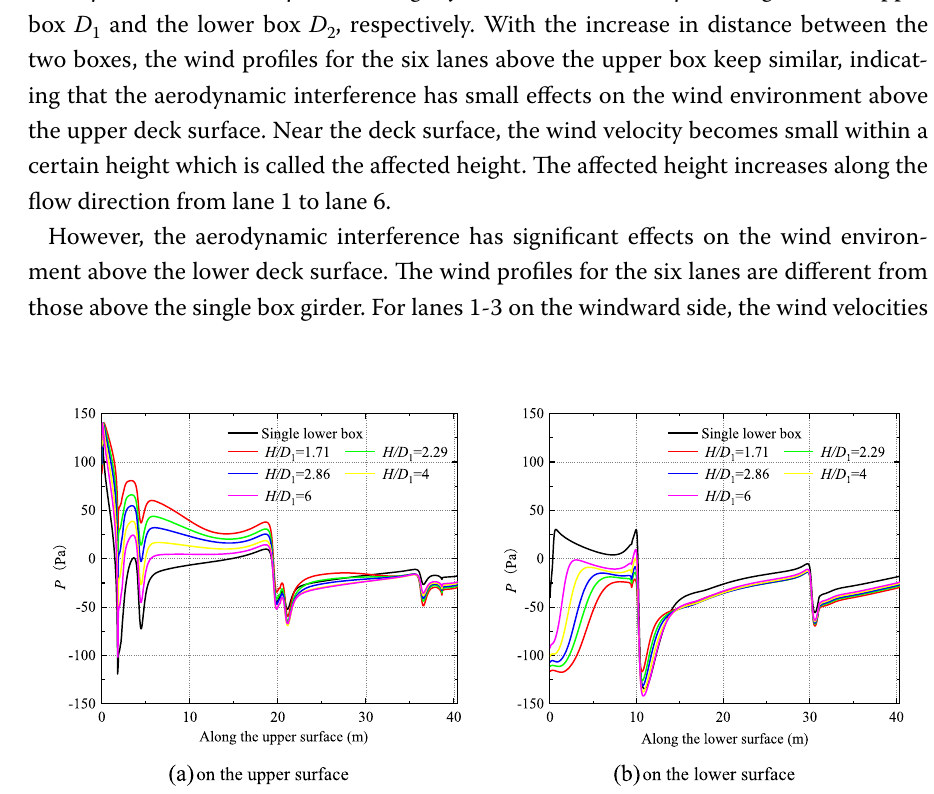
Fig. 11 Distributions of the static pressure on the lower